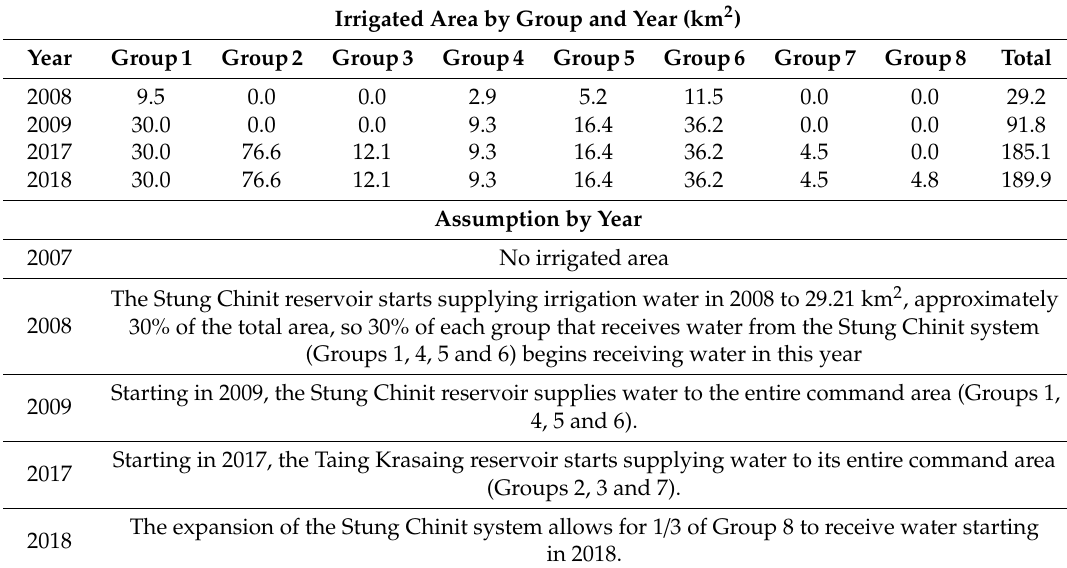
Table 1. Description of irrigated areas in the historical period as included in the WEAP model and the underlying assumptions. Basis of assumptions is further explained in the reservoir section of this paper, Section 3.1.5. Prior to 2007, there is no irrigated area within the basin; therefore, the irrigated catchments do not model any area in the historical period during this time. Starting in 2007, however, the area modeled in these catchments increases according to the areas listed below. Before, after and between years, irrigated area is held